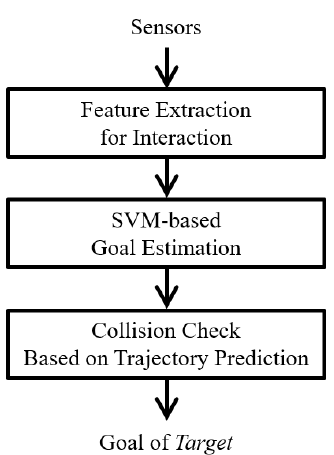
Figure 3. Schematic of the proposed method. The proposed method is comprised of three parts. As the output, the goal of lane-changing performed by the target is estimated among the four candidates: A , B , C , and D